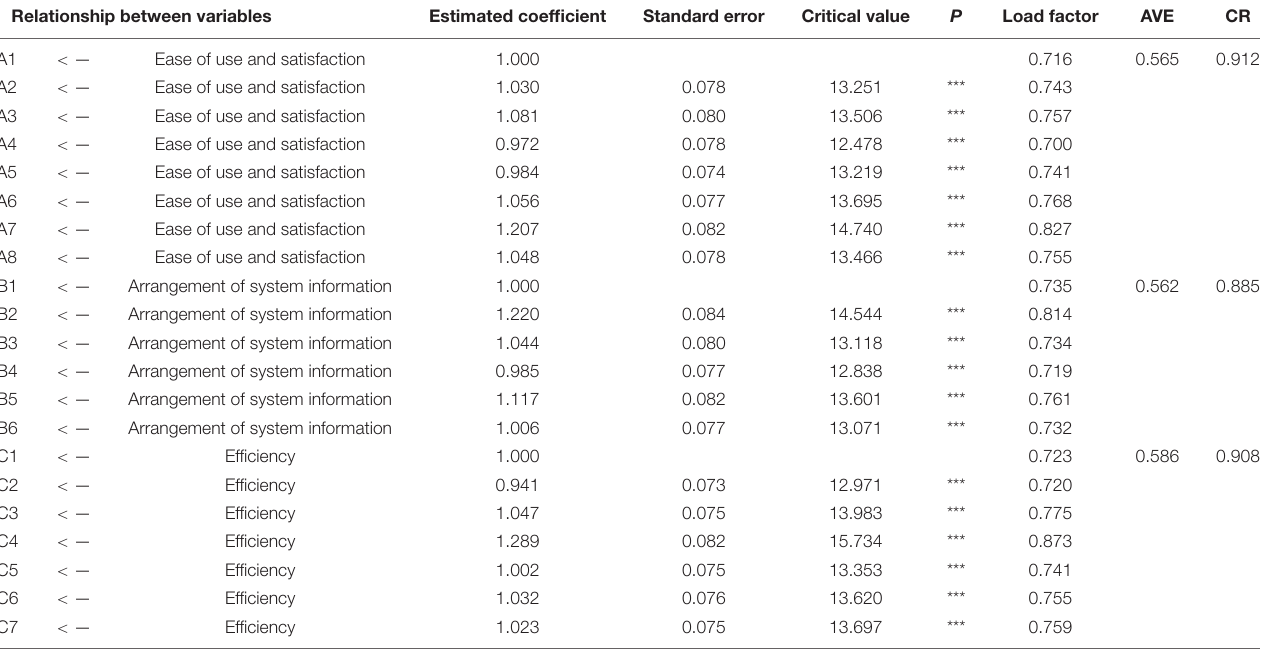
TABLE 8 | The results of the convergent validity analysis.